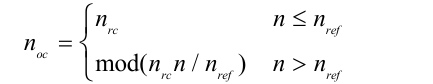
Table 1 Test result of artificial models to algorithm